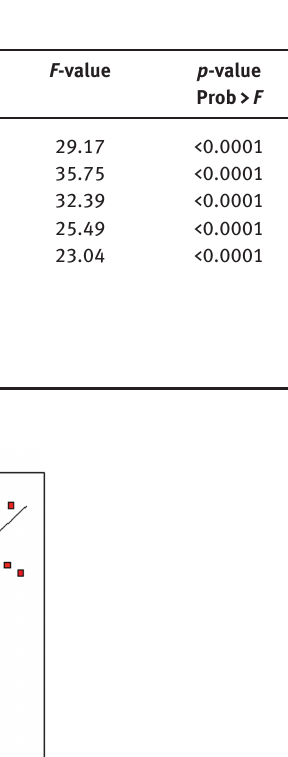
Figure 5: Linear model. (a) Normal prob- ability plot of the residuals and (b) plot of actual versus predicted weld bowing